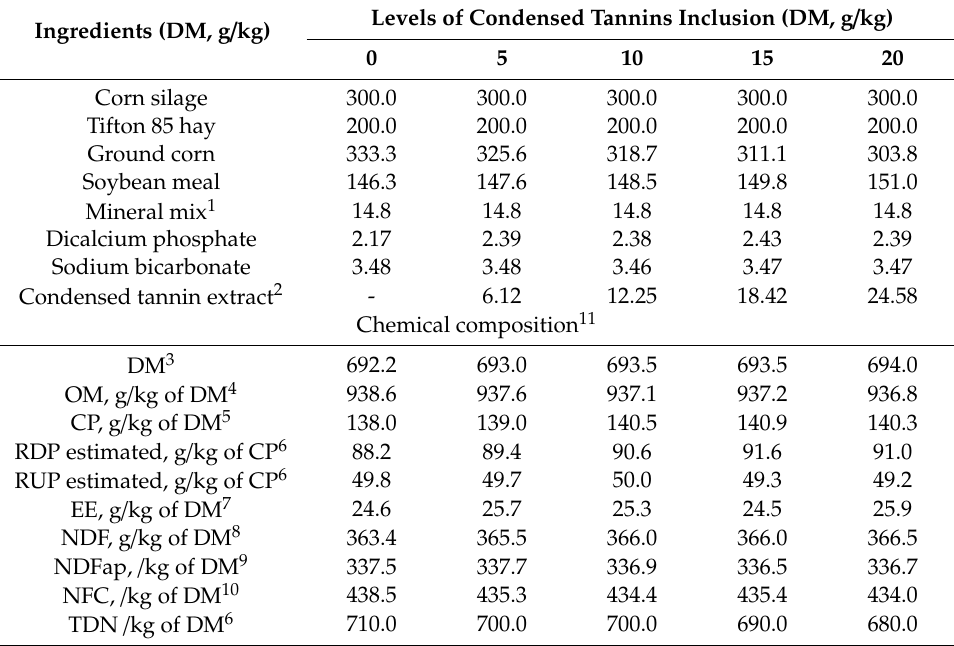
Table 2. Ingredients proportions and chemical composition of experimental diets (DM, g / kg). Ingredients (DM, g /